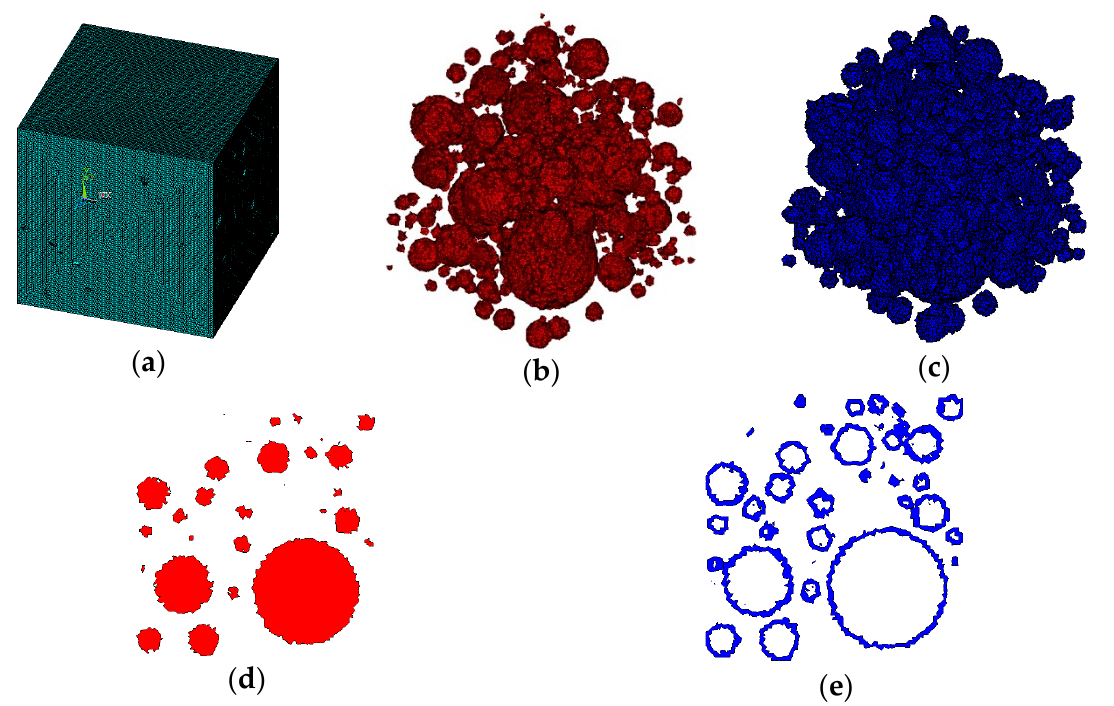
Figure 4. Mesh diagram of mortar, aggregate and ITZ elements in the spherical aggregate model, ( a ) Mortar elements, ( b ) aggregate elements, ( c ) ITZ elements, ( d ) Aggregate elements on the profile, ( e ) ITZ elements on the profile.